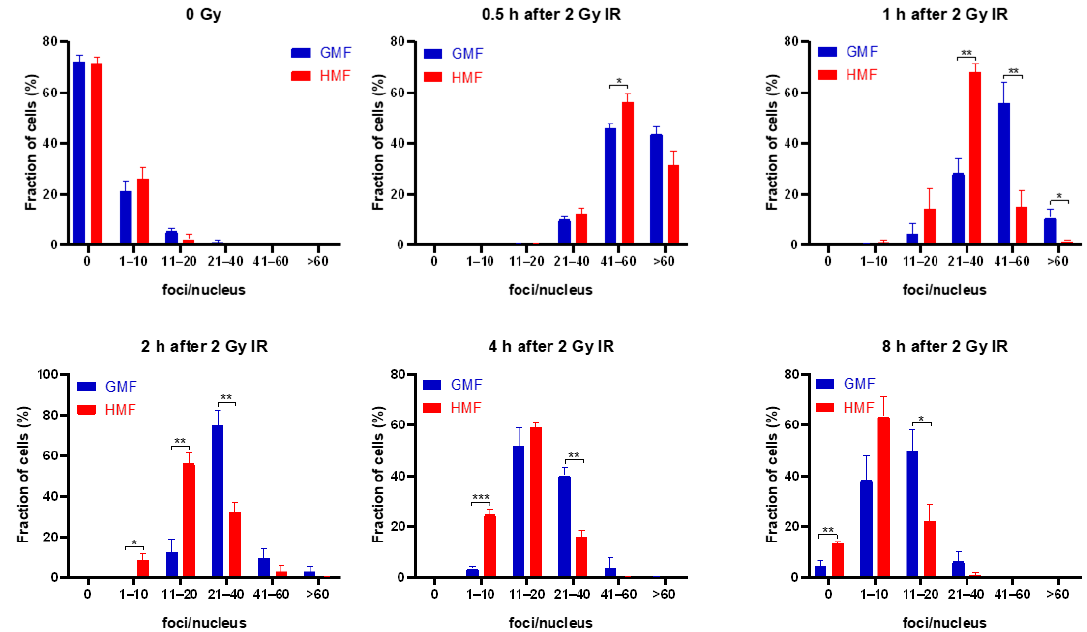
Figure 4. Fraction of cells (% ± SEM) with 0, 1–10, 11–20, 21–40, 41–60, >60 γ H2AX foci/nucleus in HMF and GMF cultured cells at indicated time points after exposure to IR. Visualization and image extraction of γ H2AX foci was performed by confocal laser microscopy following immunofluorescence staining. After obtaining a distribution of cells with the counted numbers of foci per nucleus, the fraction of cells with appropriate foci number in an indicated range was determined. Results represent the mean of 3–4 independent experiments ± SEM (* p < 0.05, ** p < 0.01, *** p < 0.001, ANOVA). The cellular level of phosphorylated H2AX was assessed by Western blotting in non-irradiated and irradiated BEAS-2B cells maintained in HMF or GMF. As shown in Figure 5, γ H2AX was induced by IR at 30 min after irradiation with a similar expression up to 2 h in both magnetic field conditions. At 4 h after irradiation, γ H2AX level slightly decreased in GMF, but persisted in HMF. At 8 h post IR, decreased γ H2AX was determined in both HMF and GMF groups. Taken together, the data above suggested that HMF may play an important role in cell recovery from γ H2AX foci positive DSB sites after irradiation.